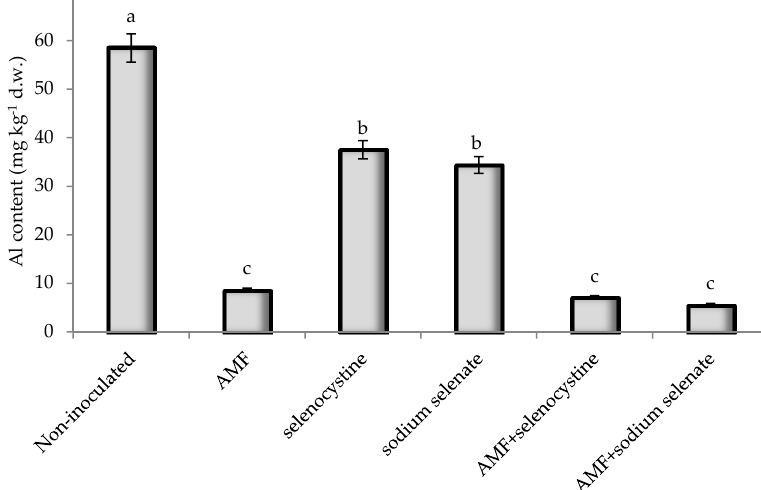
Figure 4. Aluminum content in shallot bulbs as a ff ected by microorganism inoculation and selenium treatment. Values followed by di ff erent letters are statistically di ff erent according to Duncan’s test at p ≤ 0.05 with three replicates per